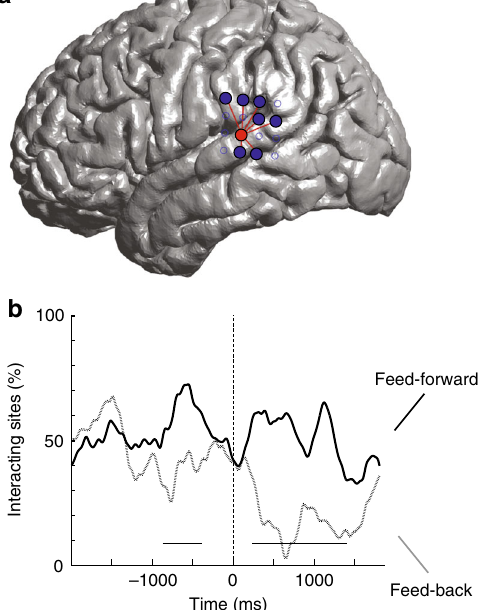
Fig. 6 Interaction dynamics during the production of functional morphemes across the TPJ. a The spatial distribution of functional interactions for one representative recording site prior to articulation onset. b Percentage of sites that displayed signi fi cant functional interaction by time series analysis. Feed-forward interactions (i.e., from sites that differentiated between the syntactic and control conditions) are displayed in black and feed-back interactions are displayed in gray. The underlined areas represent time periods during which there was a signi fi cant difference in directional